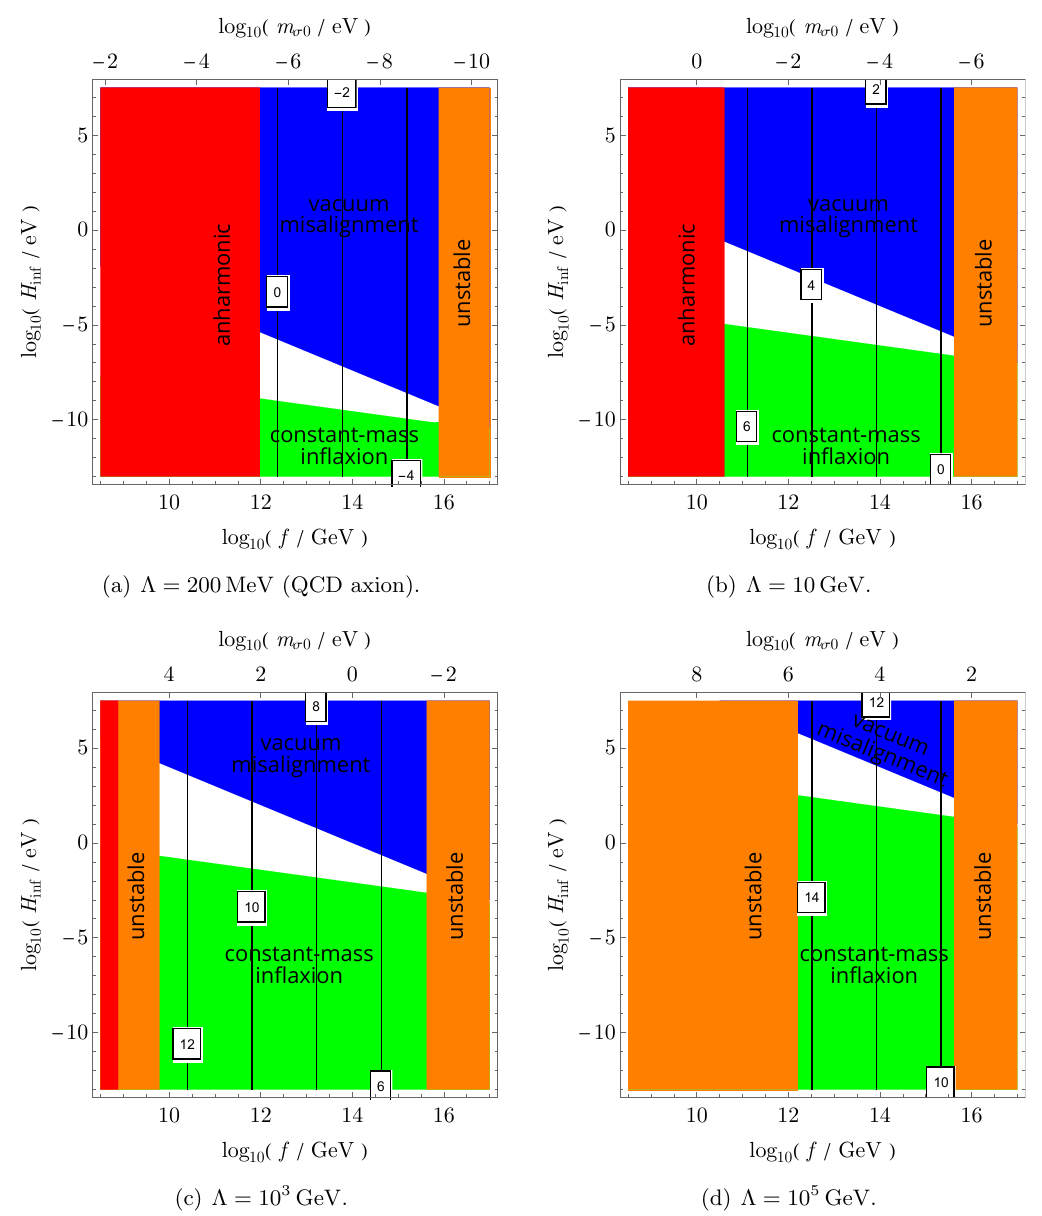
Figure 4 . Parameter space for axion dark matter in the temperature-dependent in(cid:13)axion scenario, shown for the QCD axion and axion-like particles with di(cid:11)erent values of the strong coupling scale (cid:3). Axes are axion decay constant (bottom), zero-temperature axion mass (top), and in(cid:13)ationary Hub- ble scale (left). The allowed windows are shown in white. Colored regions lie outside the validity of our analysis since the following conditions are violated: m (cid:27) 0 > H inf (blue), m (cid:27) ( T max ) < H inf (green), negligible axion self-interaction (red), and dark matter stability (orange). Contour lines show the in(cid:13)aton mass at the vacuum in terms of log ( m (cid:30) 0 = eV). The in(cid:13)aton-axion mixing con- 10 stant is set to (cid:11) = 1 = 3, and the in(cid:13)aton is coupled to fermions with g (cid:30)ff = 10 (cid:0) 2 . See the text for more details.